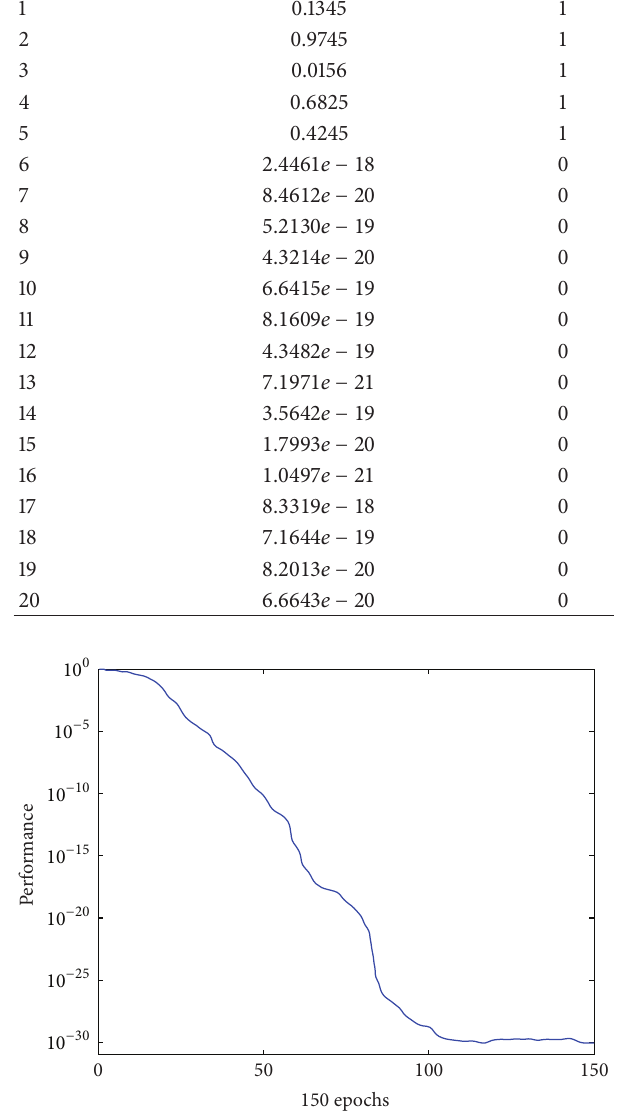
Figure 4: The RBFNN trained by